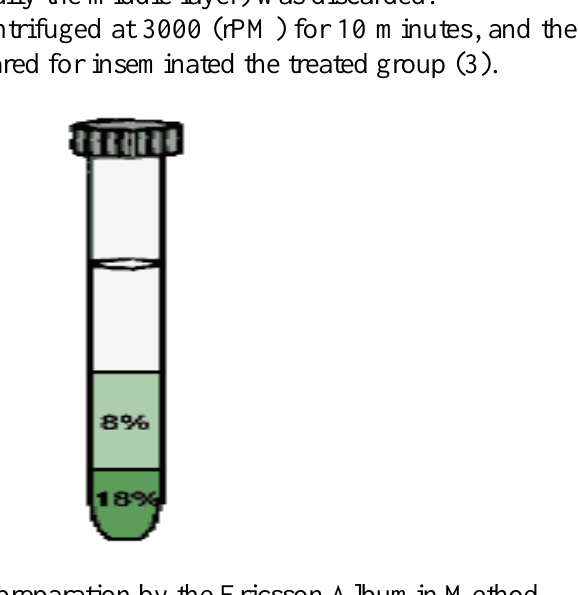
Figure 5: Mice sperms preparation by the Ericsson Albumin Method.